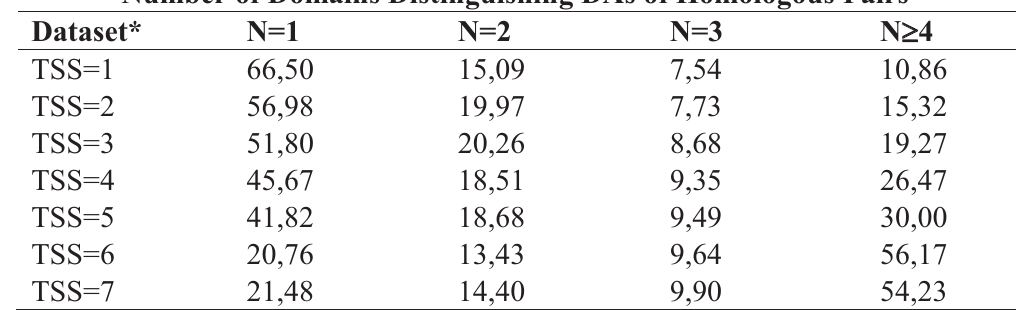
Table S4. Proportion of homologous pairs of human Swiss-Prot sequences that differ in 1, 2, 3, or ≥4 domains.